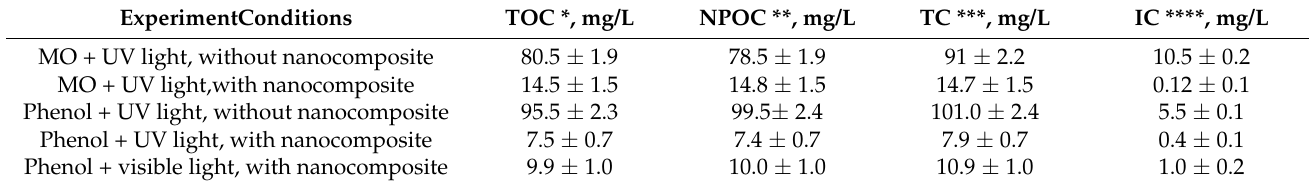
Table 2. Total organic carbon content in water before and after the photocatalytic decomposition of its organic pollutants when using the polymeric nanocomposite [( ≡ TiO) n ]:[HEMA]:[AN] = 1:5:1 + Ag NPs.